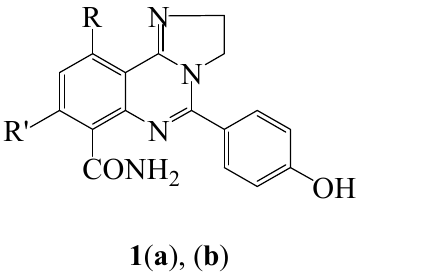
Figure 1. Examples of biologically-relevant imidazo[1,2- c ]quinazolines. 1 : R = -C 6 H 5 , R ′ = -CF 3 ( a ); R = -CF 3 , R ′ = -C 6 H 5 ( b ) and 2 .